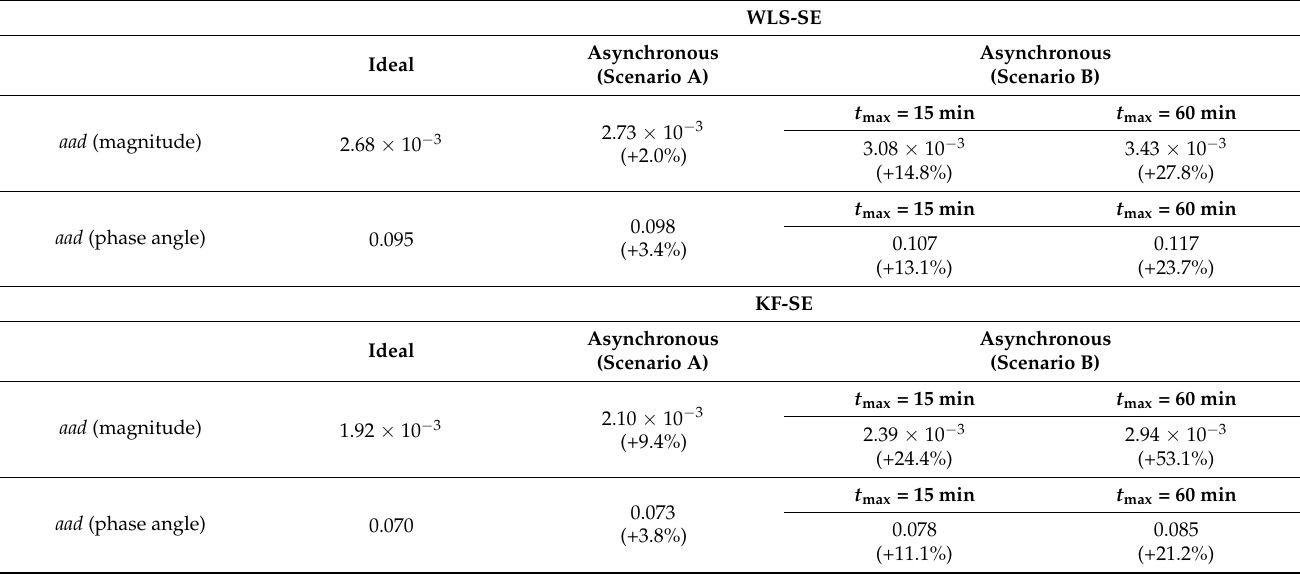
Figure 10. Estimated state values at node 122 considering data nonsynchronicity and time delays. Table 3. Total average absolute deviations considering data nonsynchronicity and time delays.